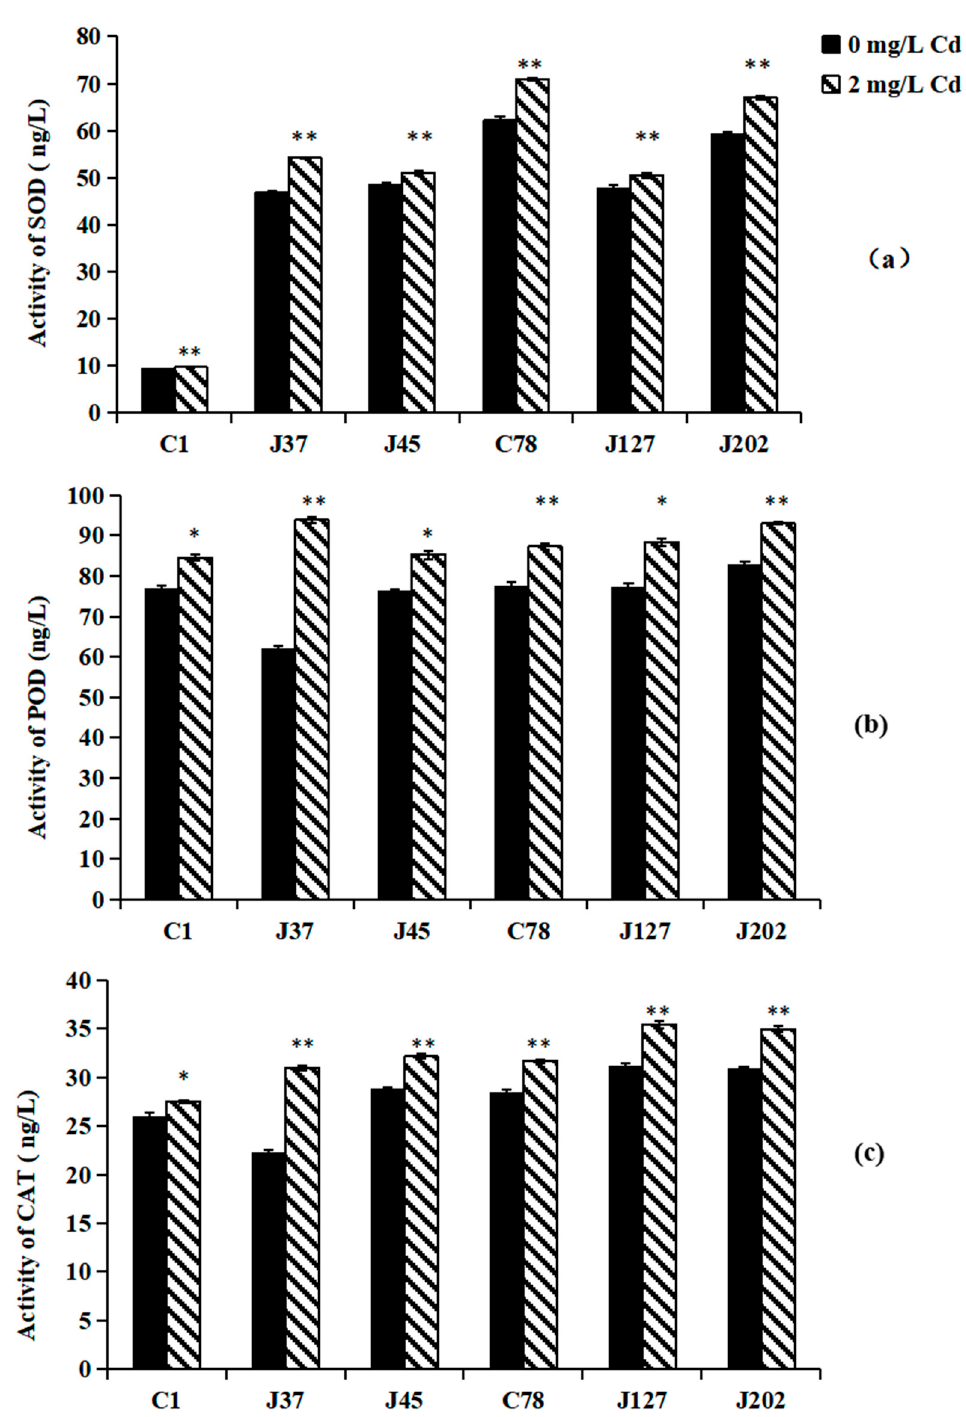
Figure 2. The activities of SOD ( a ), POD ( b ), and CAT ( c ) in the mycelia of six C. geophilum strains. Data were shown mean ± SD of replicates ( n = 3). Significant difference of the activities of SOD, POD, and CAT after Cd treatment was analyzed by the student’s t -test. * p < 0.05; ** p < 0.001.